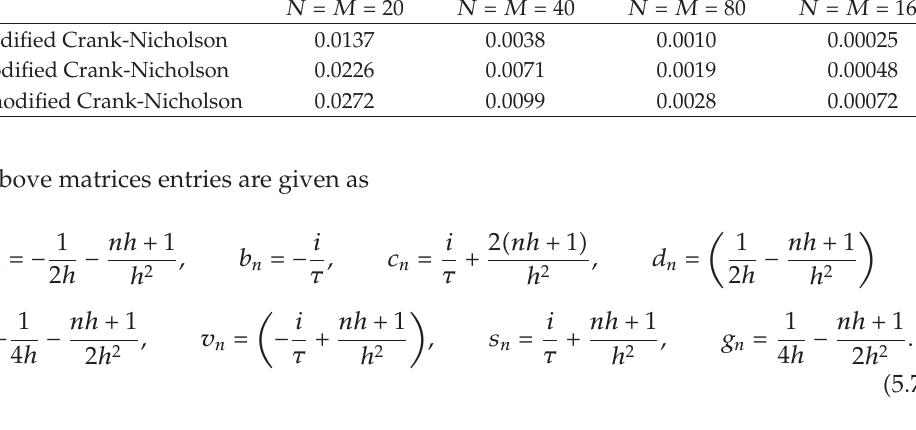
Table 1: Comparison of the errors for the approximate solution of problem (cid:3) 5.1 (cid:4) .